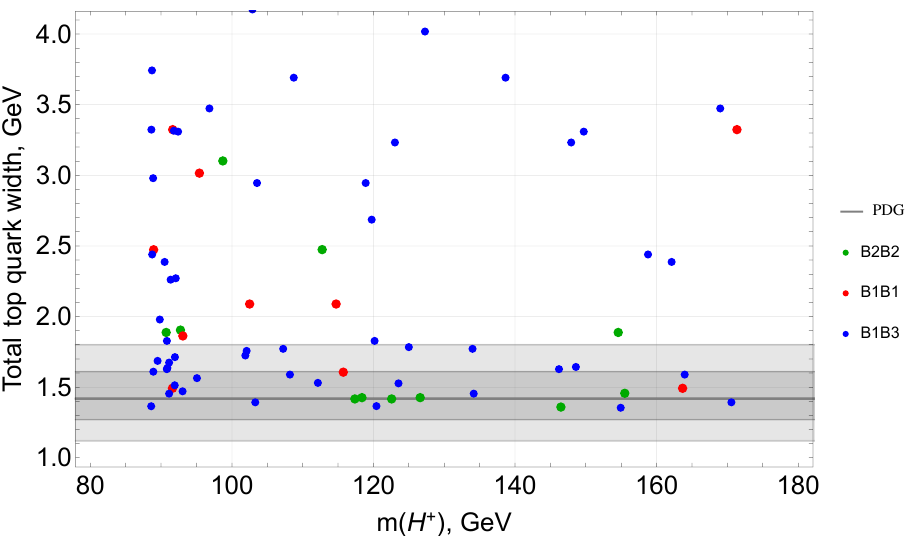
Figure 1. The total top-quark width calculated as the SM contribution plus all the t → H + a d j contributions for all the parameter space points used. Different colors correspond to the three Yukawa sector combinations. The shaded regions cover ± 1 σ and ± 2 σ regions around the central PDG